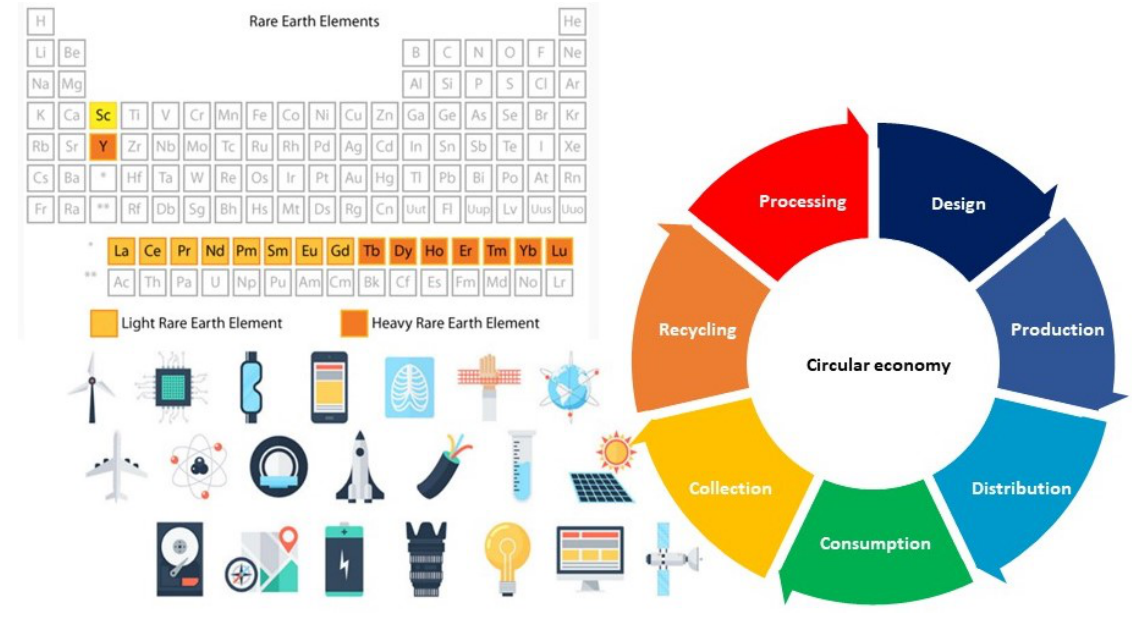
Figure 1. Circular economy and REEs recovery.